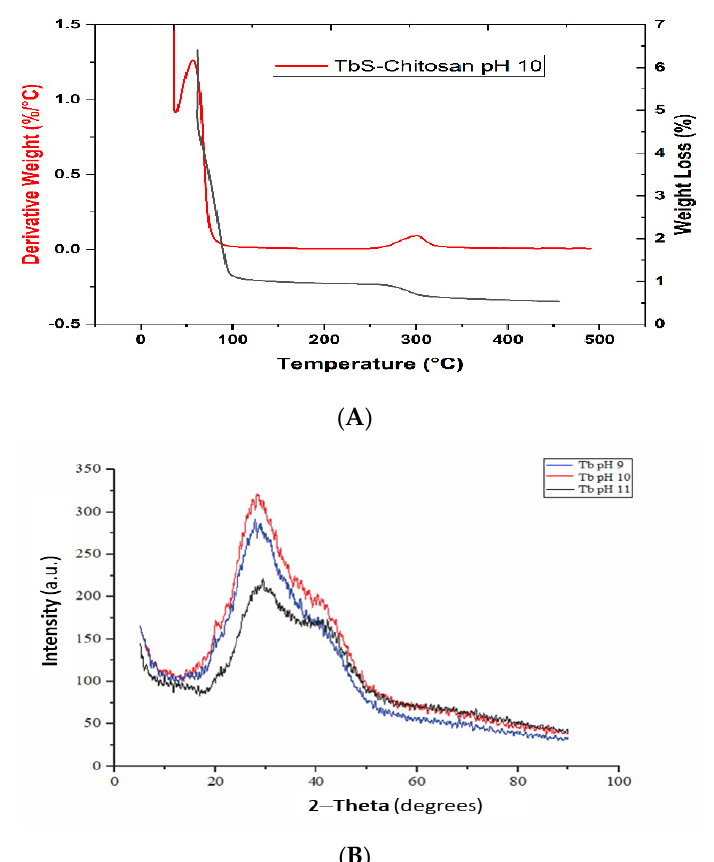
Figure 3. TGA and XRD profiles for the CS-Tb 2 S 3 nanocomposites (pH 10): ( A ) TGA weight loss (%) and derivative weight loss (%/ ° C), and ( B ) XRD intensity versus 2 θ values for nanoparticles prepared between pH 9 and 11.